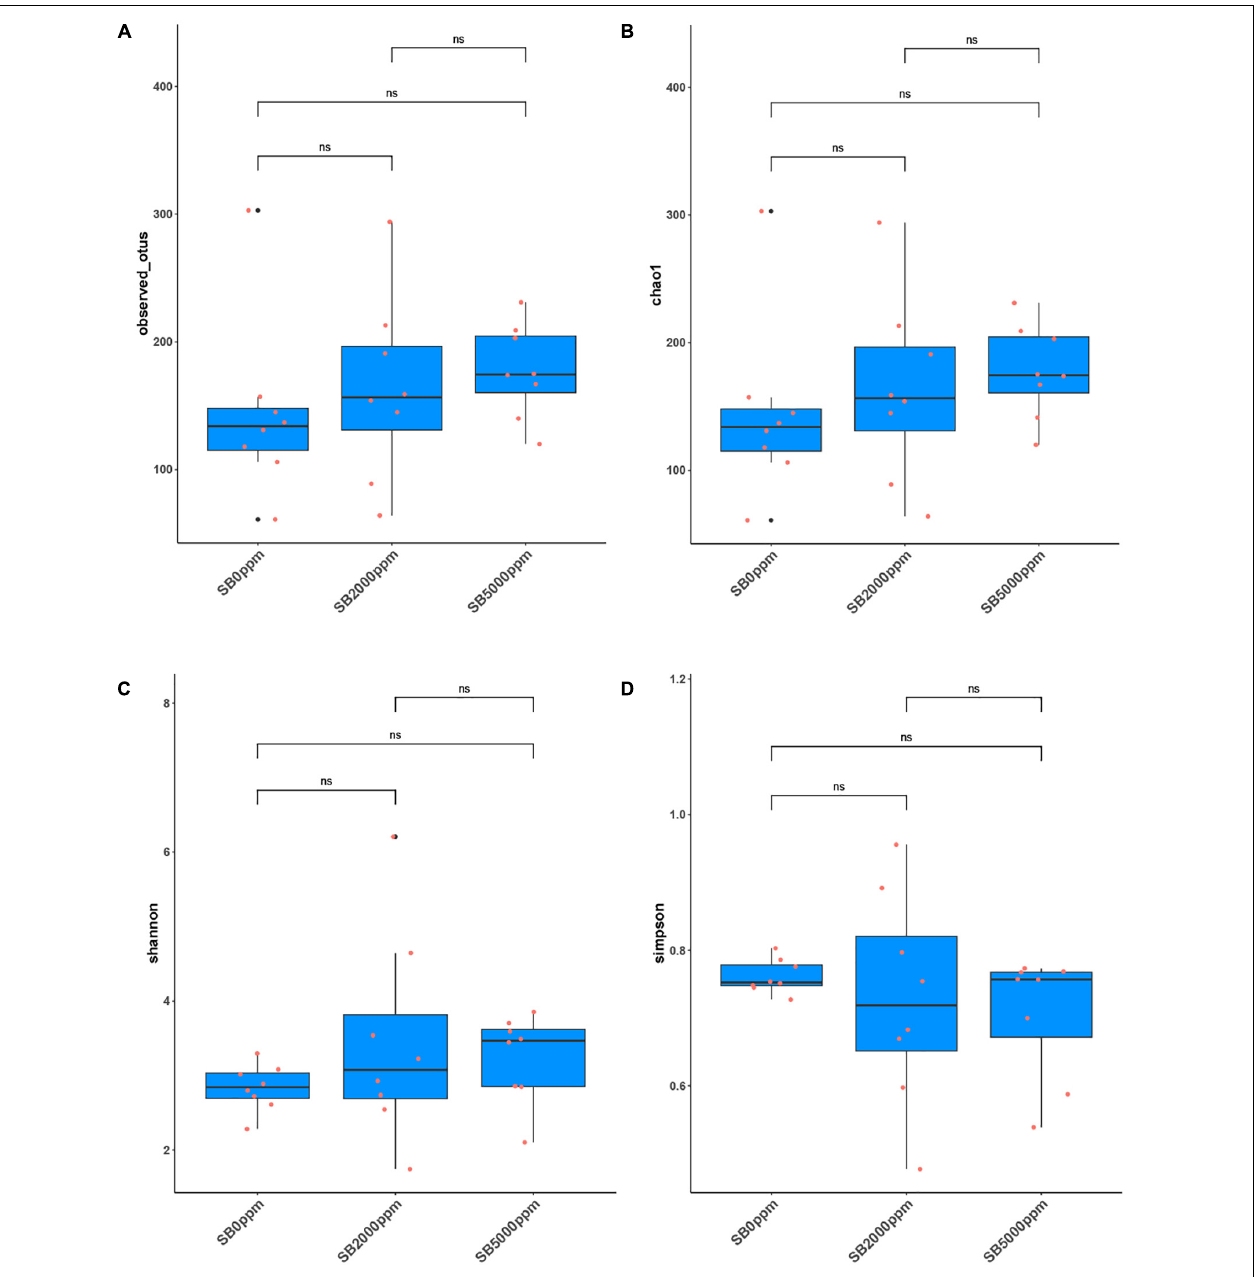
FIGURE 4 | Alpha diversity of flies’ commensal microbiota fed with SB at the genus level of Wolbachia -excluded data. (A) Observed OTUs. (B) Chao1. (C) Shannon. (D)